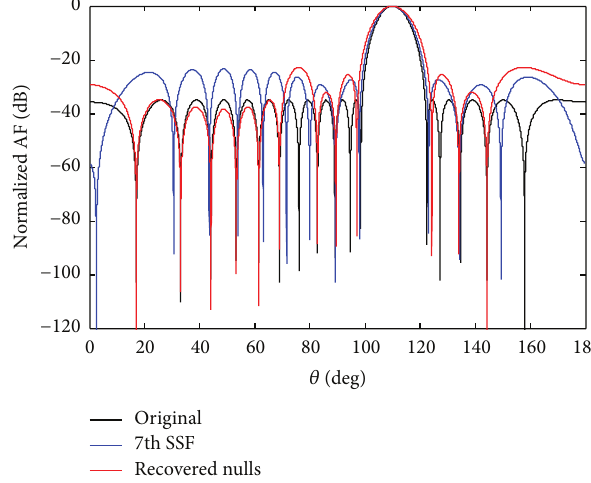
Figure 14: The original radiation pattern, the 𝑤 1 sensor failure, and recovery of one null.